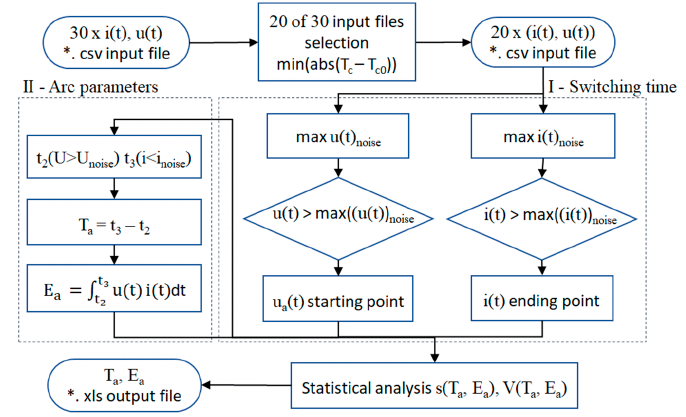
Figure 5. Matlab script operation diagram: max u(t) noise , max i(t) noise —maximum value of voltage and current noise signal, u a (t), i a (t)—voltage and current time related arc